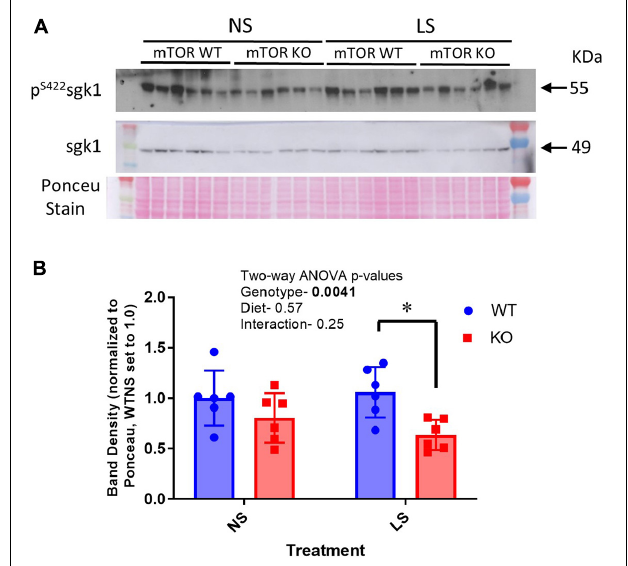
FIGURE 10 | Phosphorylation of SGK1 is reduced in KO kidney. (A) A western blot of cortex homogenates from NS and LS diet fed male mice probed with an antibody against phosphorylated SGK1 (pS422). (B) Mean band densities (mean ± sem) normalized to Ponceau stain. Two-way ANOVA p -values are shown within the panel; ∗ indicates a significant ( p < 0.05) difference between